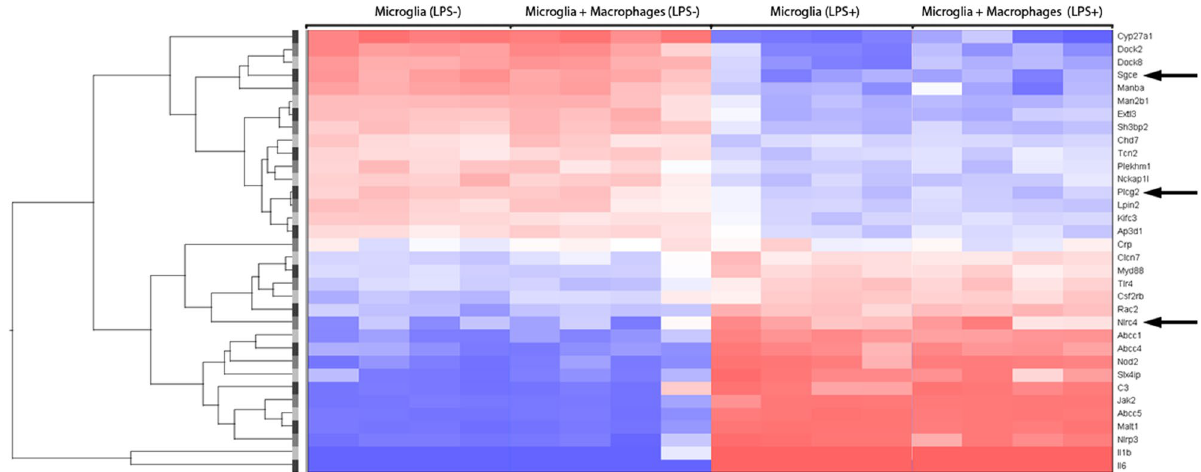
Figure 3. Heat map of LPS-mediated gene expression in microglia. Microarray gene expression data (GSE102482) from Greenhalgh et al. were analyzed to determine the expression pattern of a subset of 148 autism and pediatric immune disorder genes. The heat map shows the data obtained from RNA extracted from microglia grown on their own or co-cultured with peripheral macrophages. Arrows point to differentially expressed genes that are PANS candidates described in this report.